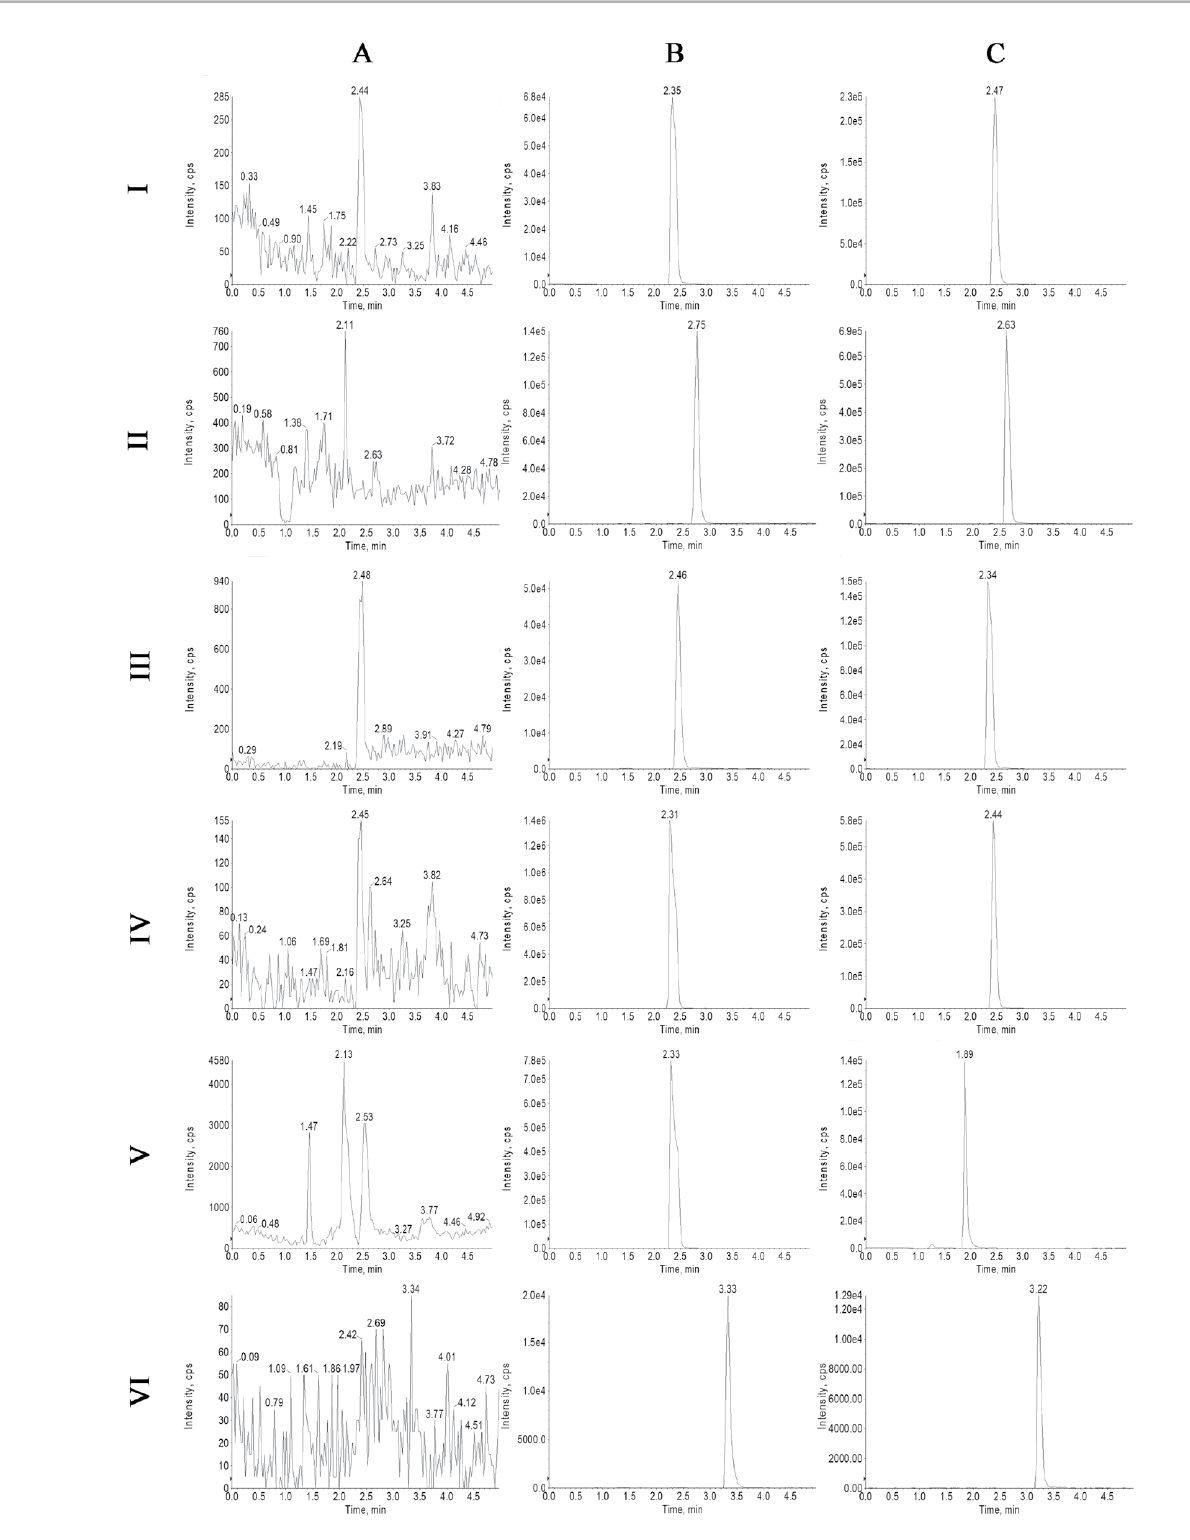
FIGURE 1 – LC-MS/MS chromatograms of probes and the internal standard in SD rats plasma. A. Blank plasma; B. Blank plasma + Probe substrate +Internal standard; C. Probe substrate after tail vein injection of probe substrate in rat +Internal standard; (I. midazolam; II. phenacetin; III. dextromethorphan; IV. omeprazole; V. amodiaquine; VI.